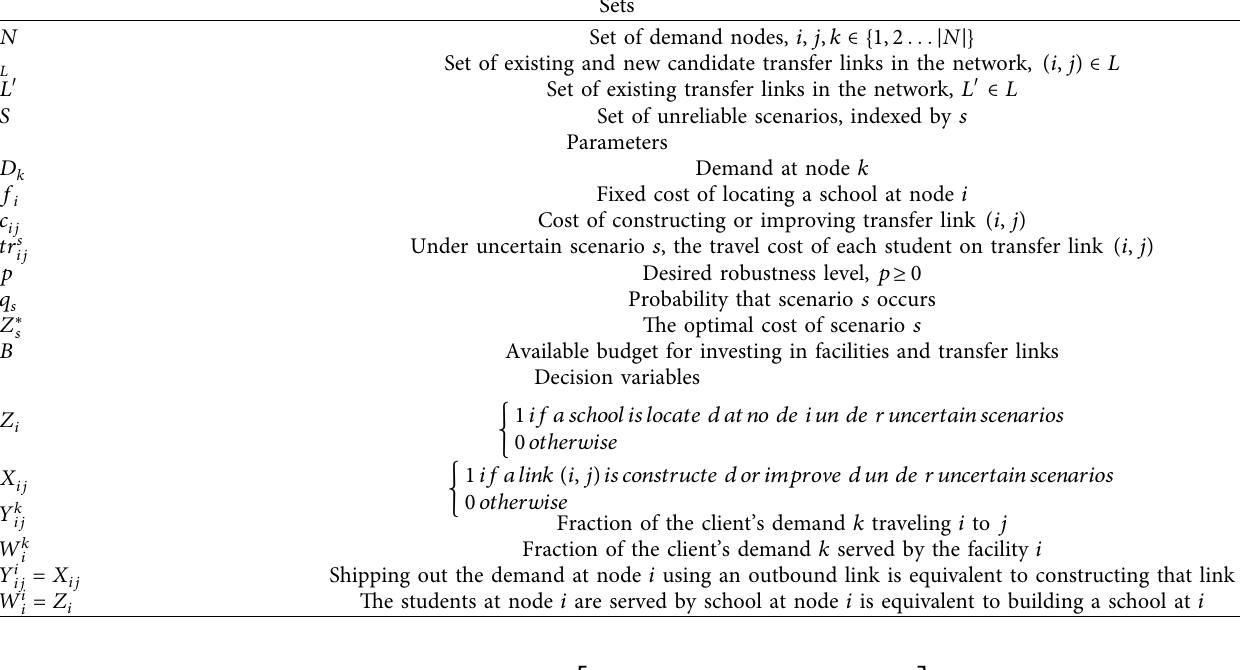
Table 1: The notations of the proposed problem.